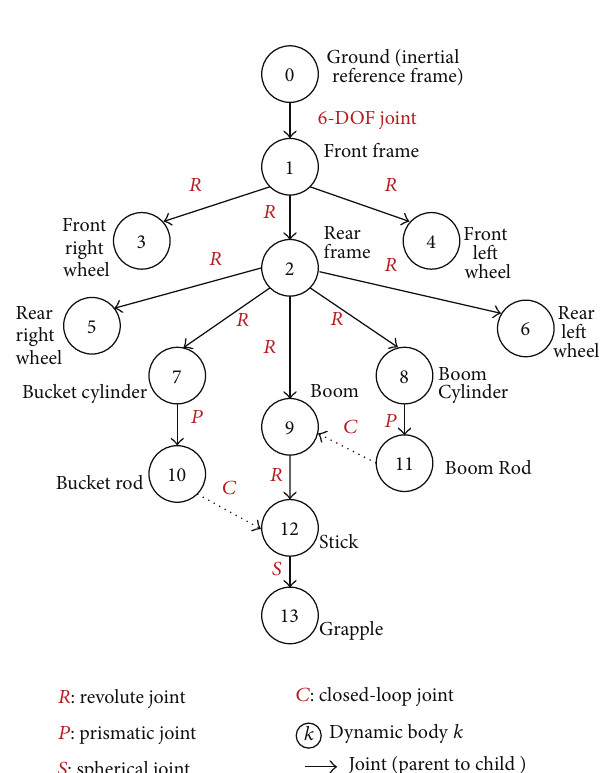
Figure 12: Kinematic tree of log dragging forestry